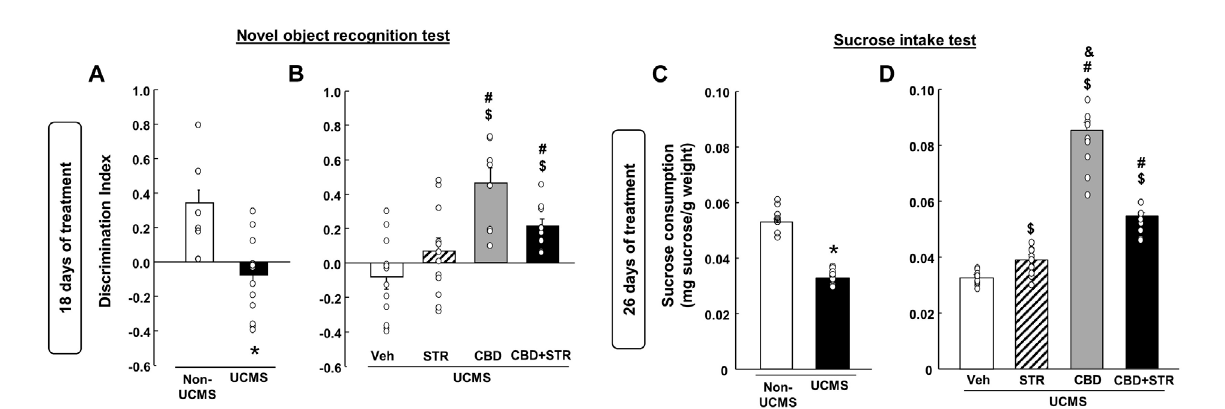
FIGURE 4 Chronic effects of treatment with CBD, STR or their combination in modulating cognitive impairment and anhedonia in mice exposed to the unpredictable chronic mild stress model (UCMS) . Panels (A, B) Novel Object Recognition Test (NOR) and panels (C, D) sucrose intake. Columns represent the means and vertical lines the ±SEM of each parameter evaluated. * Values from the VEH-treated UCMS group that differ signi fi cantly from VEH-treated non-UCMS group (Student ’ s t-test, p < 0.05). $ Values from STR-, CBD- and/or CBD + STR-treated UCMS mice that were different from the VEH-treated UCMS group. # Values from CBD- and/or CBD + STR-treated UCMS mice that were different from STR-treated UCMS mice. and Values from CBD-treated UCMS mice that were different from CBD + STR treated UCMS mice (One-way ANOVA followed by Student-Newman-Keuls, p <